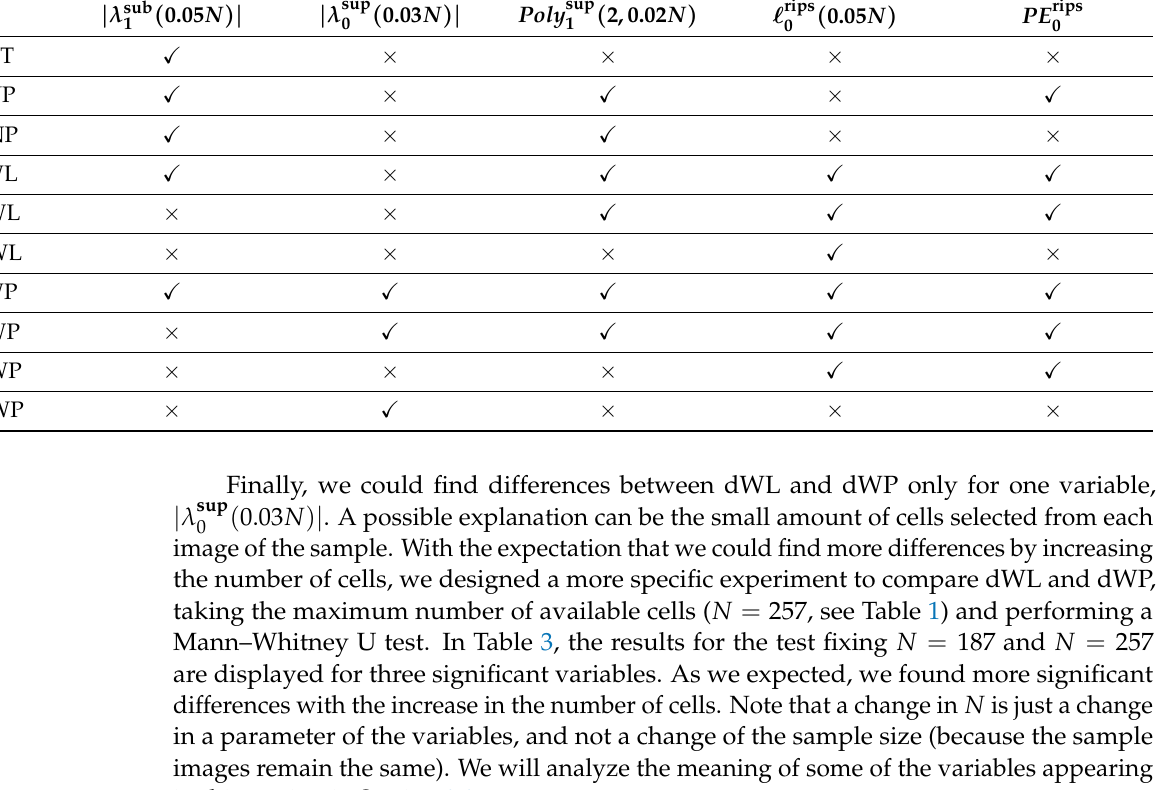
Table 2. Differences between the tissues for 187 cells. A check mark implies that the p -value of that variable is smaller than 0.01 in the Dunn test and a cross mark that we could not find significant differences using that variable. 187 Cells